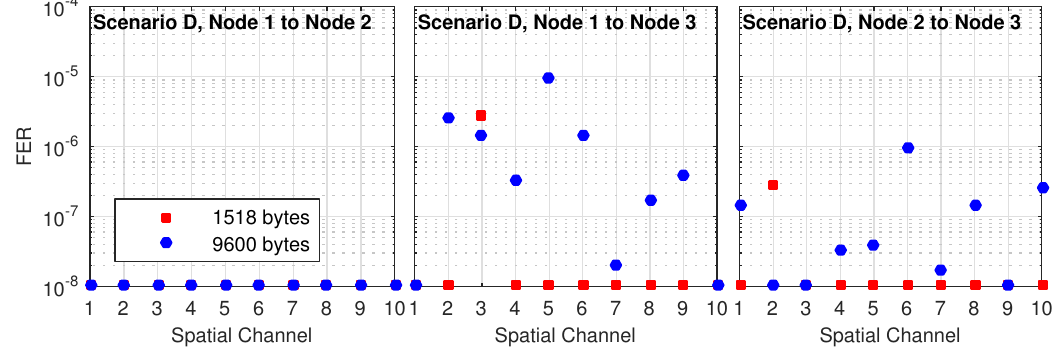
Figure 7. FER estimates from the spatial channels composing the pSSC for three cases within scenario D assuming 1518 byte and 9600 byte